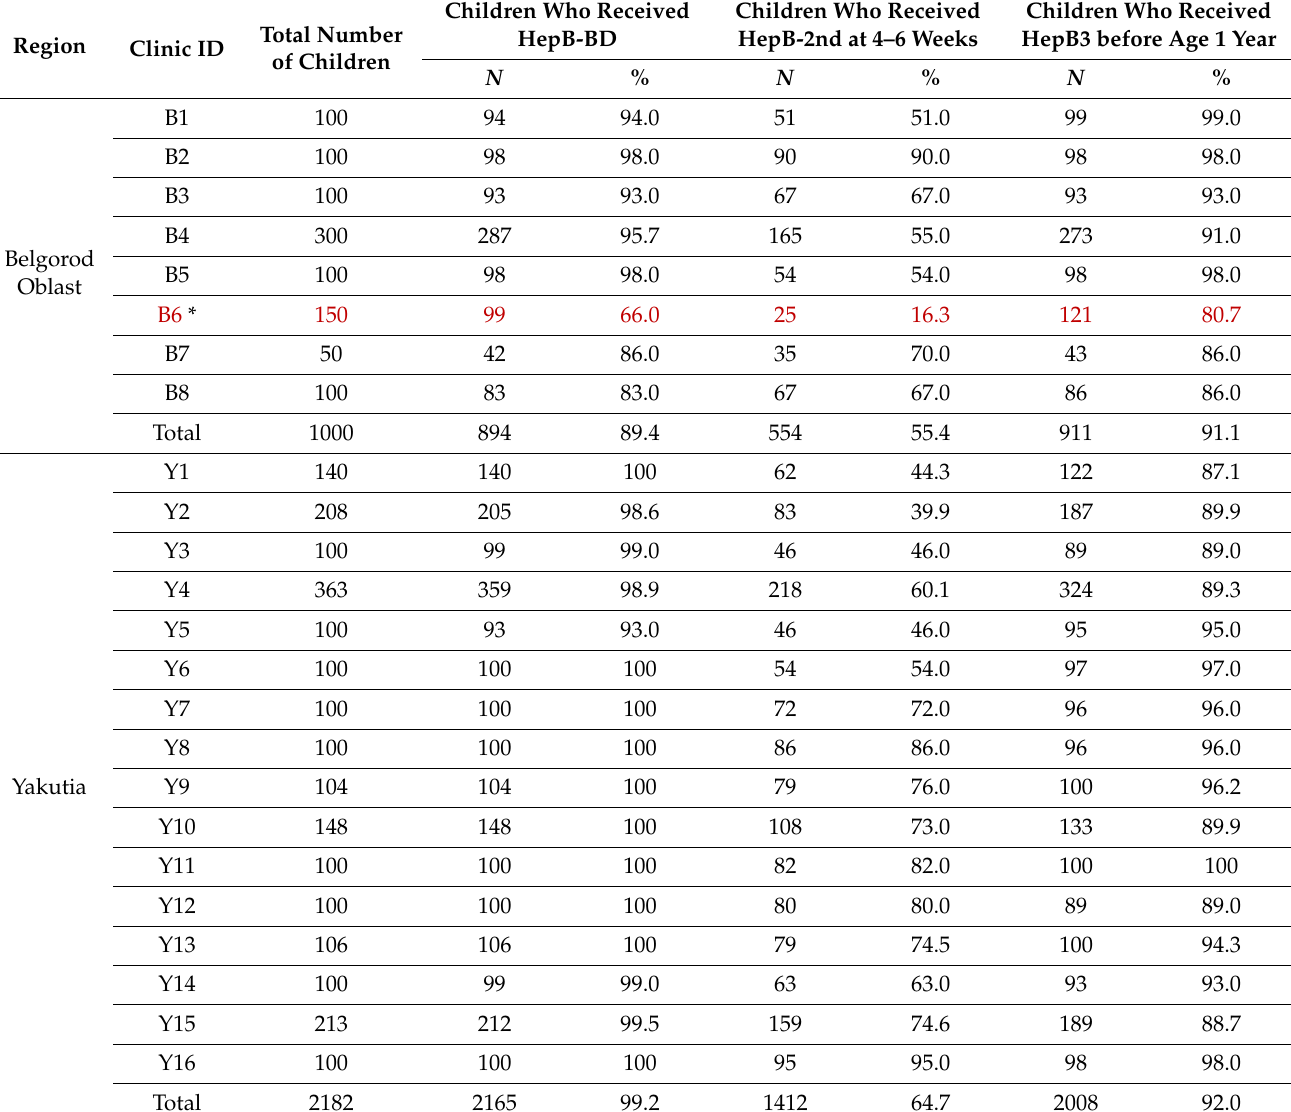
Table 1. Rates of coverage with timely HepB-BD, timely HepB-2nd and